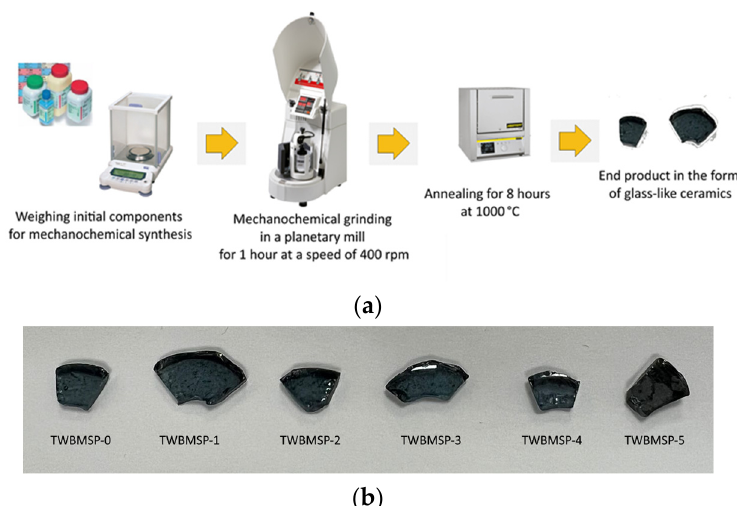
Figure 1. ( a ) Scheme for obtaining glass-like ceramics using mechanochemical grinding method and further thermal annealing; ( b ) Images of composite glass-like ceramics depending on PbO concentration. Figure 1b represents images of the obtained composite glass-like ceramics after sinter- ing in crucibles to reflect the degree of transparency and